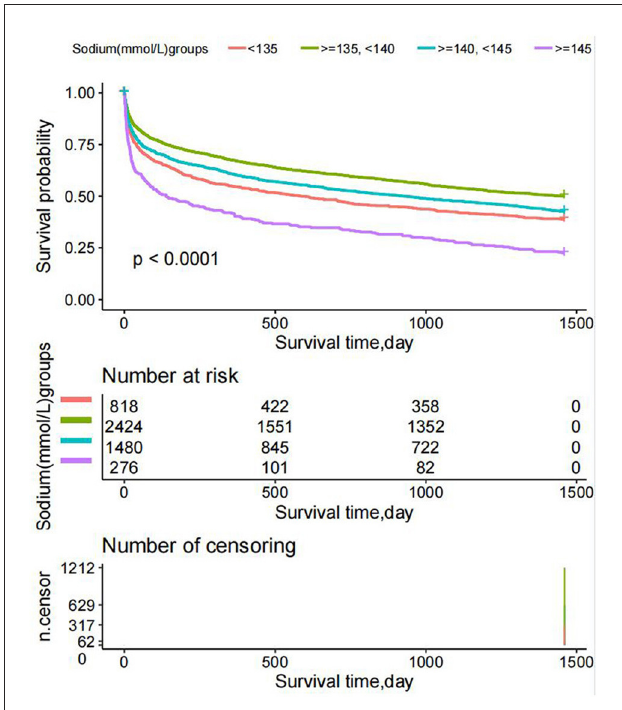
FIGURE11 Kaplan–Meier survival curves demonstrating differences in overall survival